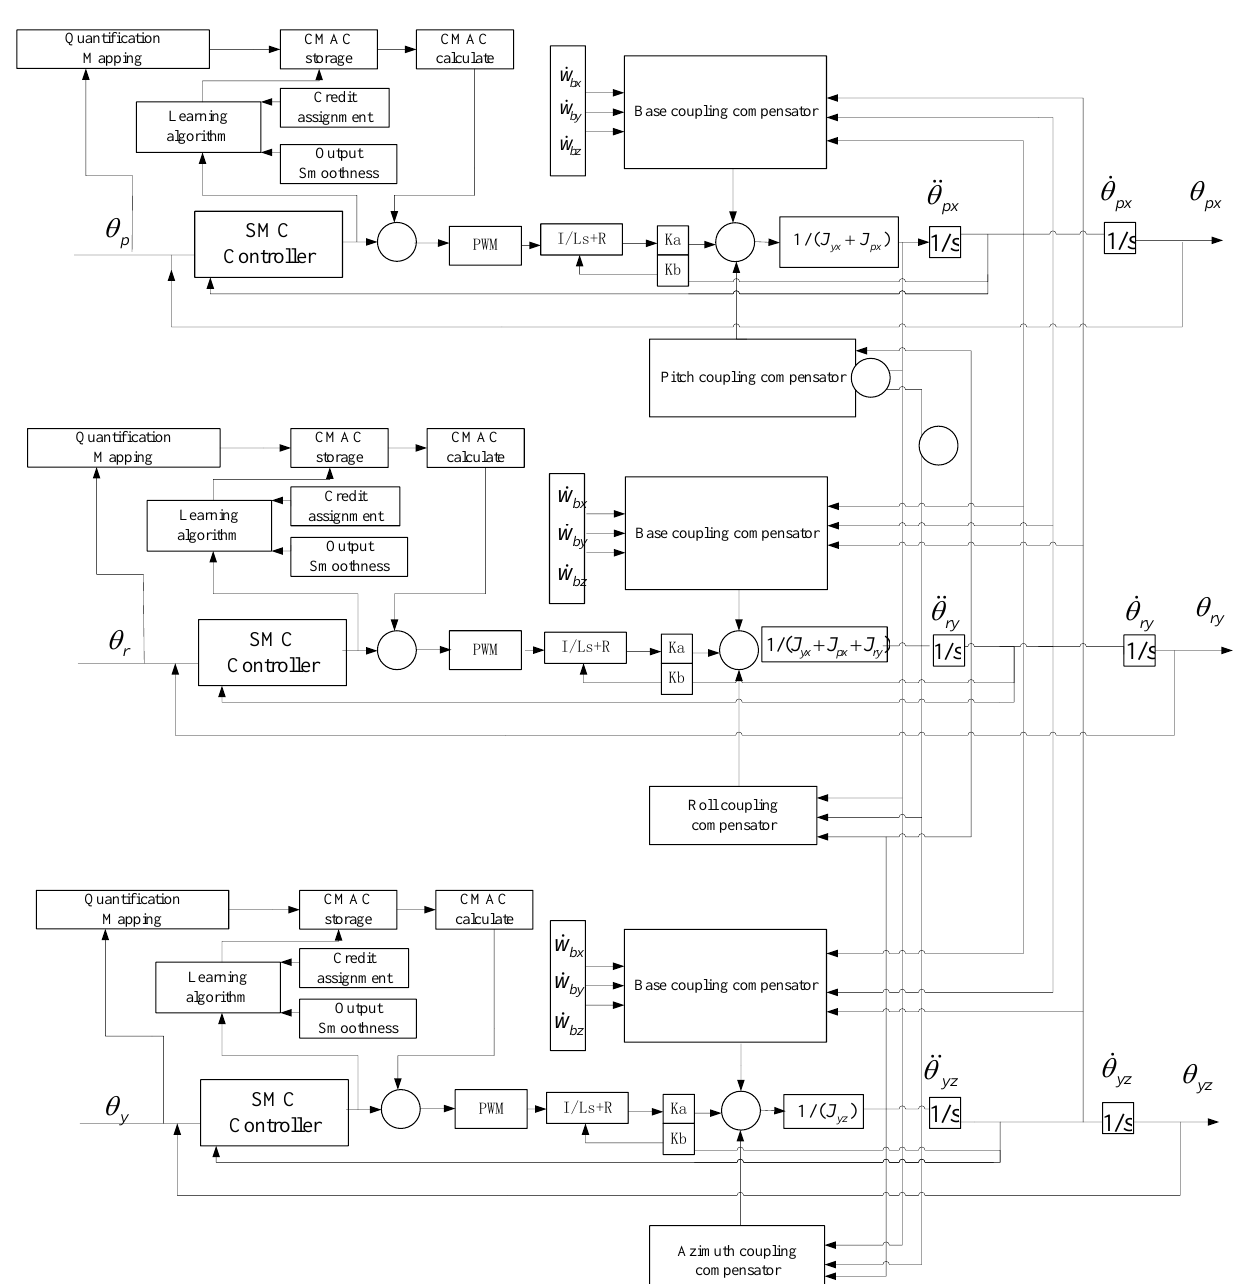
Figure 5. Structural diagram of the ARSSP control system.